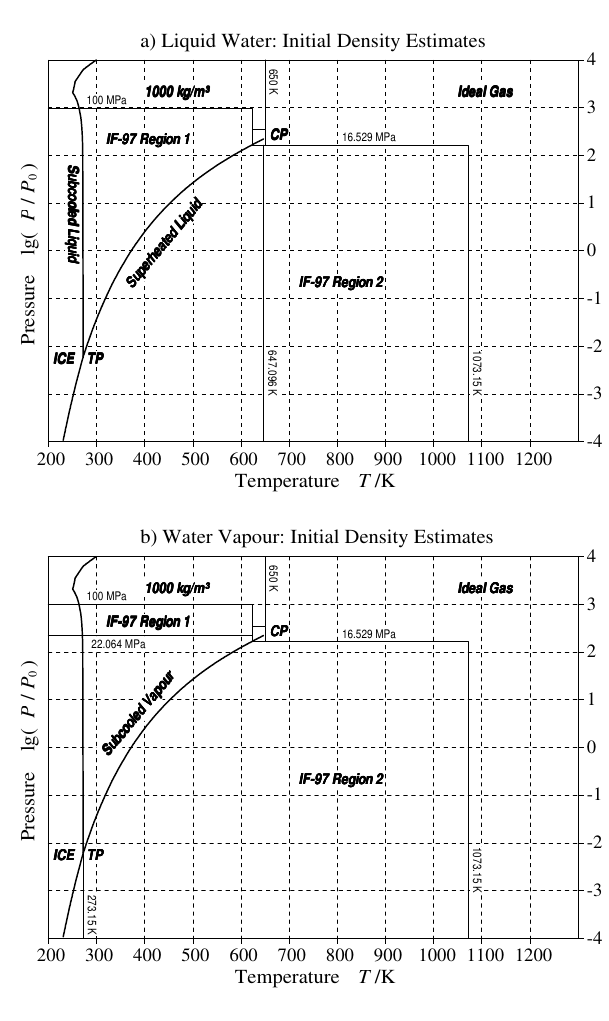
Fig. A1. Initial estimates used in the library for the numerical com- putation of density from pressure by iteratively solving Eq. (A3), either for liquid water, panel (a) , or water vapour, panel (b) . The region surrounding the critical point (CP) is treated separately, as shown in Fig. A3. Here we make use of the Gibbs functions “ g(p, T ) ” in two of the five regions defined in IF-97, region 1 (liq- uid/fluid) and region 2 (vapour/fluid) as shown in Fig. A2. Pan- els (a) and (b) differ only for subcritical conditions T <T c and P<P c ; otherwise there is only one solution corresponding to the unique Gibbs function for fluid water. TP is the ice-liquid-vapour triple point. The saturation curve connects TP with CP and sepa- rates liquid above from vapour below. To the far left, ice Ih (ICE) is separated from the liquid by the melting curve, above TP, and from the vapour by the sublimation curve, below TP. Note that the melt- ing curve above 200MPa belongs to forms of ice other than Ih, the ambient hexagonal phase. For vapour below 273.15K, the ideal-gas equation is